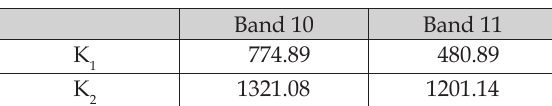
Table 3. Landsat 8 TIRS Thermal Band Calibration